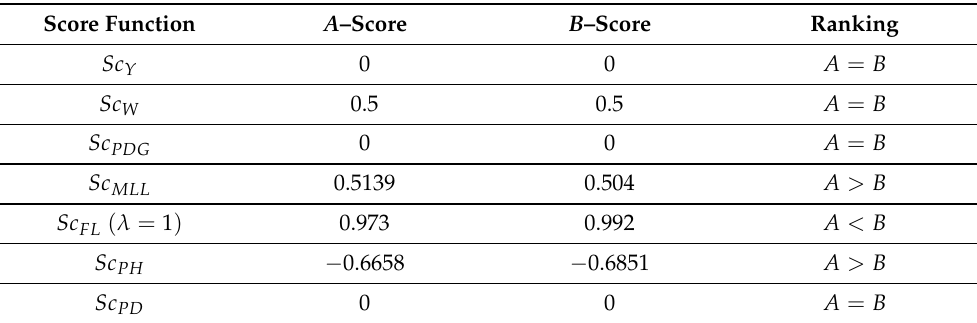
Table 3. The ranking of p − ROFS A = ( 0.3,0.3 ) and B = ( 0.2,0.2 ) with existing score functions with p = 3.